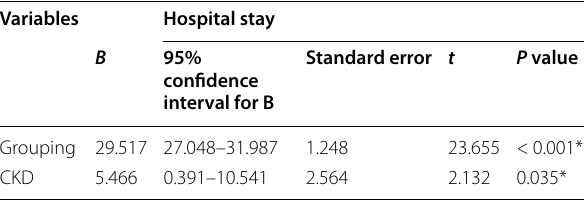
B regression coefficient, CKD chronic kidney disease, Group I used NPWT, Group II conventional wound dressing *Statistical significance at p <